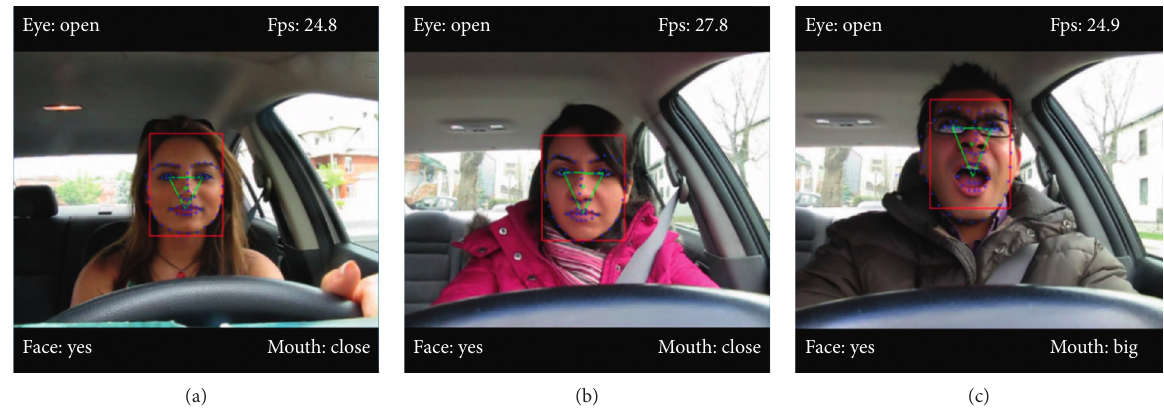
Figure 12: The detect result of YawDD data